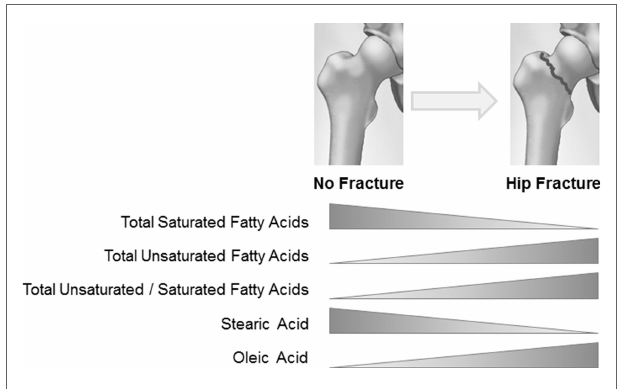
FiGUre 1 | relationship between hip fracture and fatty acid composition in the bone marrow serum of osteoporotic women